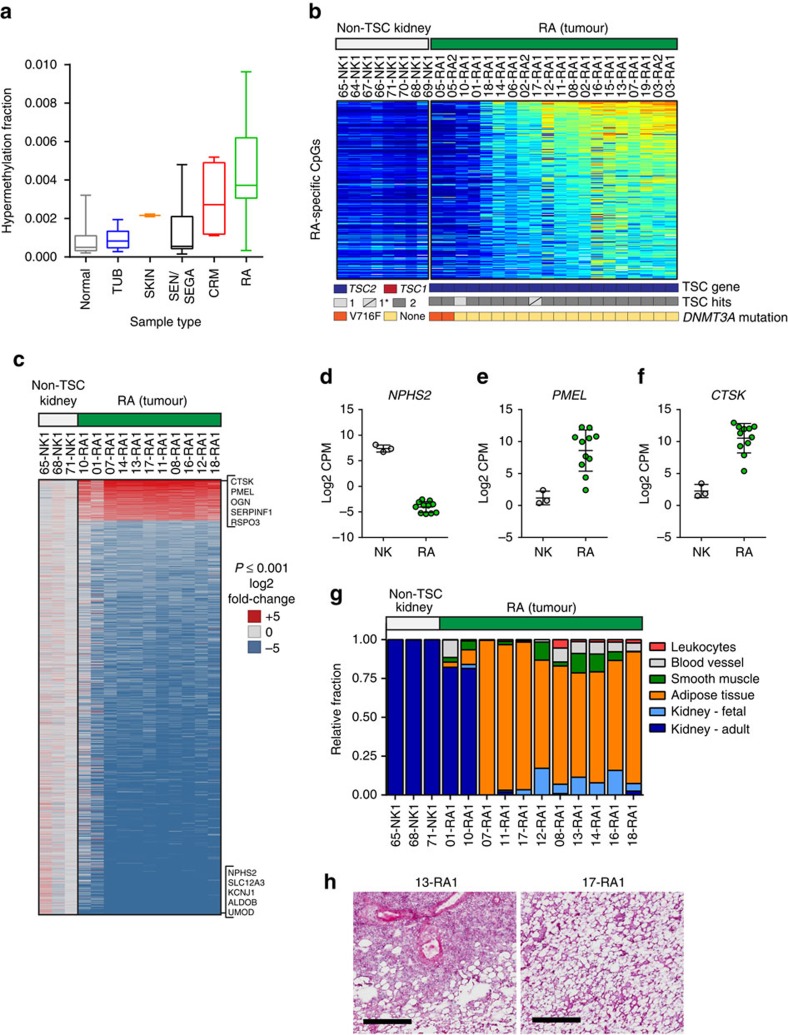
Shared methylation and transcriptional features of angiomyolipomas.(a) The hypermethylation fraction of TSC tumours (boxes: 25th to 75th percentile; whiskers: minimum to maximum; line: median). (b) 240 RA-specific probes. Probe signal intensity shown from low (blue) to high (red). Samples annotated for germline mutation (blue: TSC2; red: TSC1), 1 or 2 TSC hits (germline + somatic mutation) with ‘1*’ indicating only 1 mutation found but data from targeted TSC1/TSC2 sequencing not available, and DNMT3A status (yellow: wild-type; orange: V716F somatic mutation). (c) Genes differentially expressed in RA tumours compared to non-TSC kidney samples (log2 fold-change +/− >2; adjusted P<0.001) coloured by log2 fold-changes according to the scale (blue: low; red: high). Top 5 upregulated and downregulated DEGs are indicated. (d–f) Normalized log2 CPM values for NPHS2, PMEL and CTSK for non-TSC kidney (NK; grey) and RA (green). Symbols represent single samples. Line: mean; error bars: s.d. (n=3 non-TSC kidney; n=11 RA). (g) The relative fraction of cell types estimated by CIBERSORT (red: leukocytes; grey: blood vessel; green: smooth muscle; orange: adipose; light blue: fetal kidney; dark blue: adult kidney). (h) H&E-stained tissue sections of 13-RA (showing smooth muscle surrounding vasculature and pockets of adipose tissue) and 17-RA1 (nearly exclusive adipose tissue). Scale bars, 500 μM.